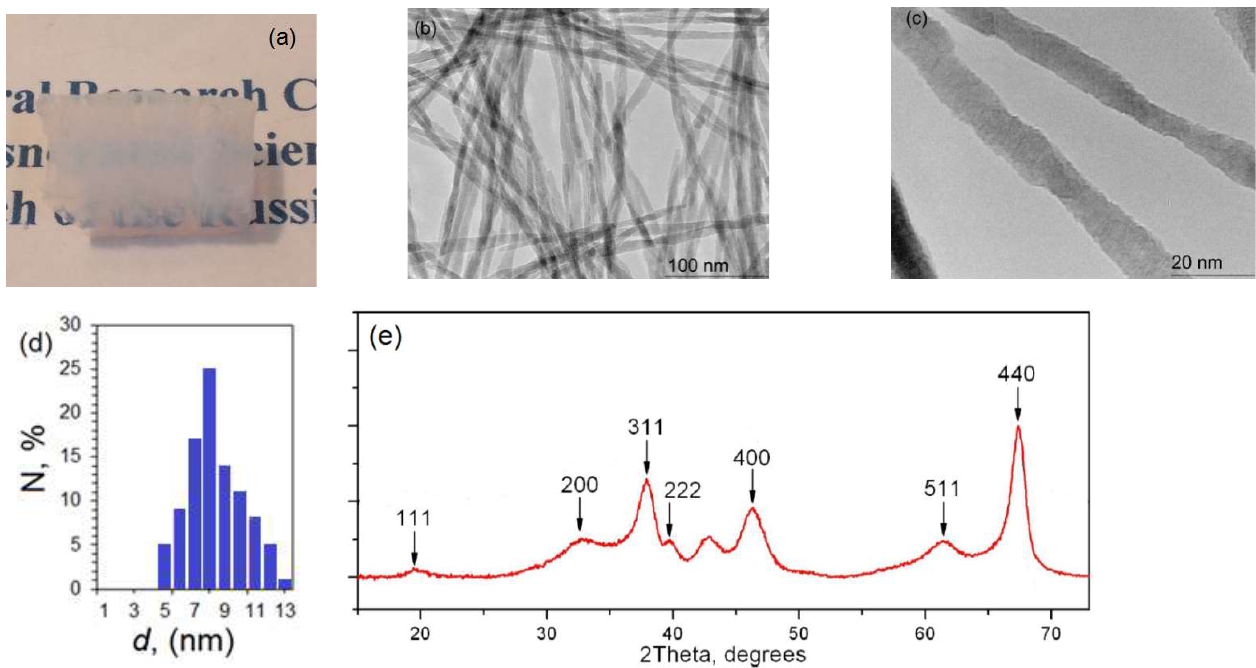
Figure 2. Morphology of the raw alumina nanofibers. ( a ) Photo, ( b ) scanning electron microscopy, ( c ) transmission electron microscopy, ( d ) histogram of a sample of nanofibers by diameter, and ( e ) X-ray phase analysis.